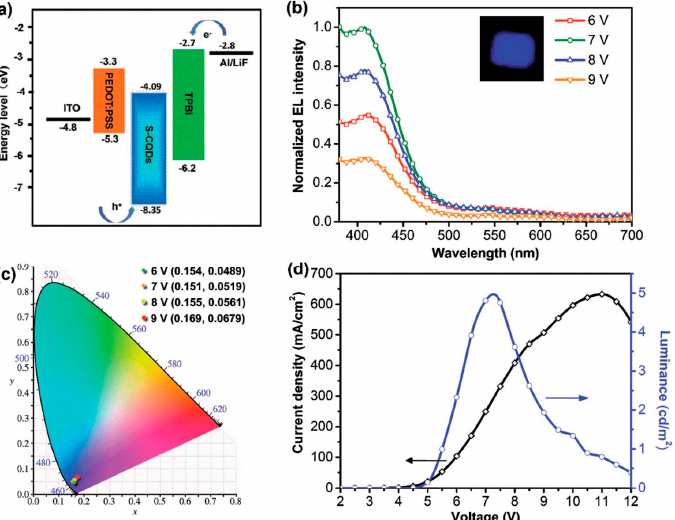
Figure 11. ( a ) The schematic energy level diagram of the CD-LEDs, ( b ) emission spectra at different working voltages (the inset is a photograph of CD-LEDs at 7 V), ( c ) the CIE 1931 chromaticity coordinates of CD-LEDs at different working voltages, and ( d ) J – L – V characteristics of CD-LEDs: Reproduced with permission from [66], copyright 2017 The Royal Society of